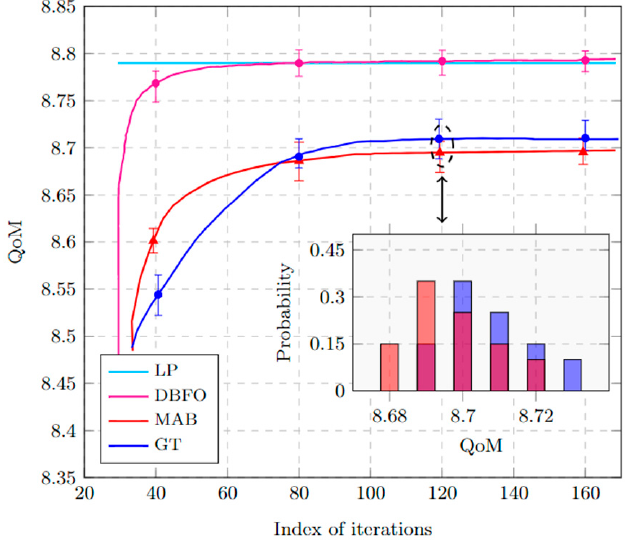
Figure 15. Performance comparison of the four algorithms.